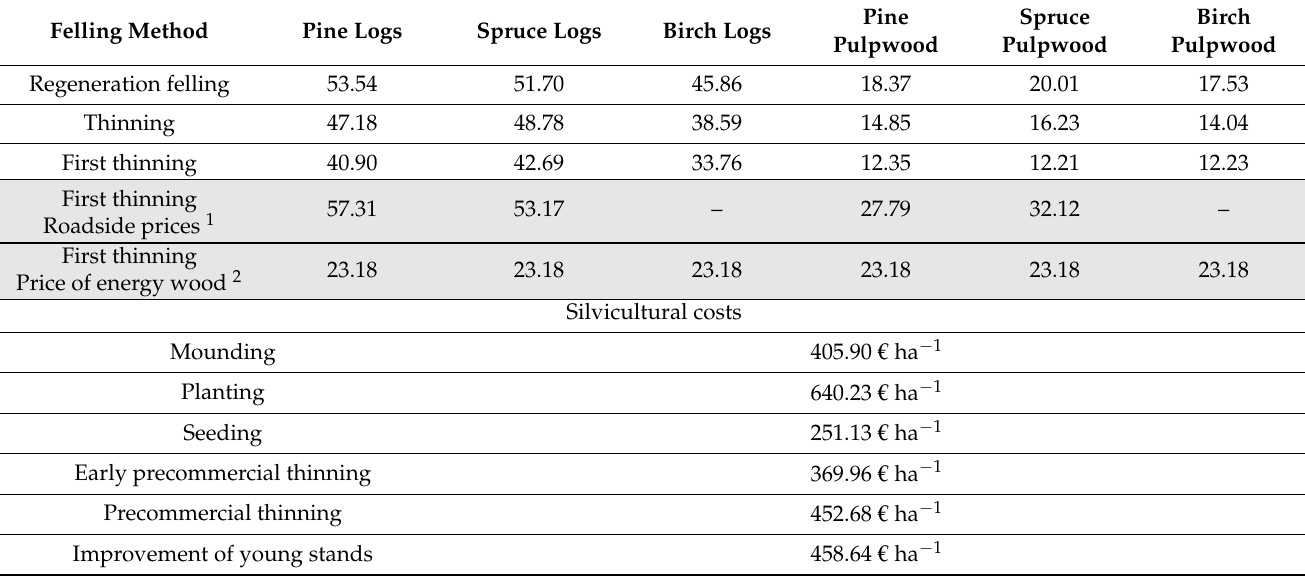
Table 2. Stumpage prices ( € m − 3 ), silvicultural costs ( € ha − 1 ), roadside prices ( € m − 3 ) and price of energy wood ( € m − 3 ) in real terms (base year 2019). Price of energy wood is at roadside. Shading refers to prices applied only for a contractor. Felling